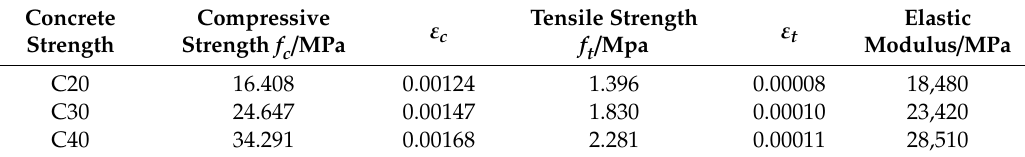
Table 10. Characteristic parameters of